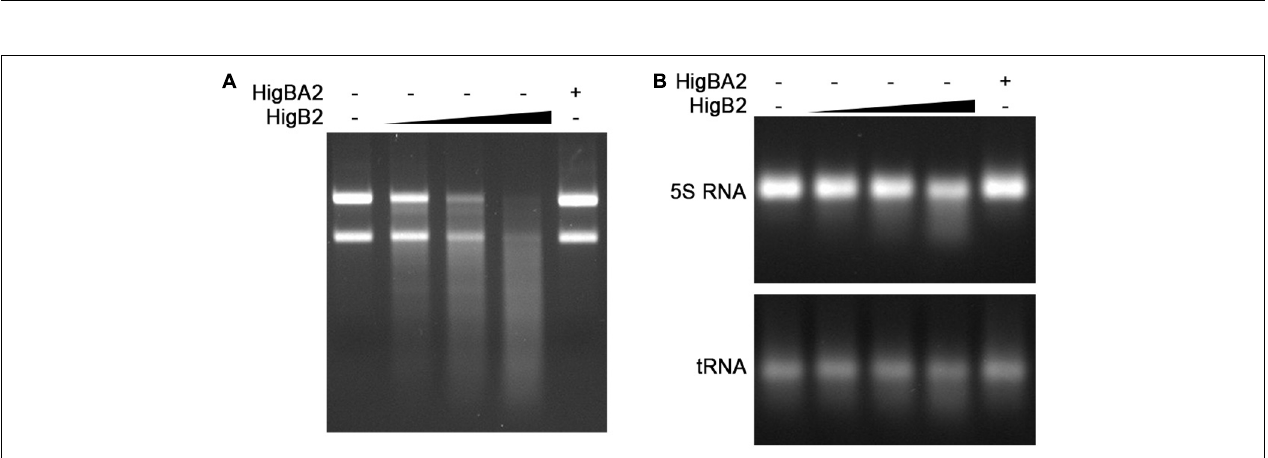
FIGURE 2 | Analysis of HigB2 Ab –HigA2 Ab protein interaction. (A) Two-hybrid analysis of interaction of toxin-antitoxin (TA) components. E. coli BTH101 with two plasmids, one encoding Cya-T18 fused to A. baumanii antitoxins HigA2 Ab or RelB Ab , and another encoding Cya-T25 fused to toxins HigB2 Ab or RelE Ab . The ability of the proteins to interact and reconstitute functional Cya from T25 and T18 was observed as blue colony formation when grown on LB agar with IPTG and X-gal for 24 h; (B) Size-exclusion chromatography and SDS–PAGE analysis of His-HigBA2 and HigBA2-His protein complexes. The proteins used for molecular mass standard curve are indicated as black diamonds, empty diamonds indicate the positions of His-HigBA2 and HigBA2-His protein complexes and single His-HigB2 protein and their calculated size; inside box – 15% SDS–PAGE gel analysis lane 1 – His-HigB2, lane 2 – His-HigBA2, lane 3 – HigBA2-His proteins and complexes after gel filtration; (C,D) E. coli BL21(DE3) strain, containing pET-HigBA-His (C) and pET-His-HigBA (D) plasmids were grown to mid-exponential phase and protein expression was induced with 1 mM IPTG for 4 h. Cells were disrupted by sonication and the His-tag containing proteins were purified by affinity chromatography from the soluble fraction as described in Section “Materials and Methods”. Proteins were visualized by 15% SDS–PAGE stained with Coomassie Brilliant Blue. M – protein molecular mass markers (band sizes in kDa are shown on the Left), –/+ cell lysate before and after induction with IPTG, S – soluble protein fraction after cell disruption, F – protein purification flow-through fraction, W – protein purification wash fraction, Elution – protein purification elution fractions.